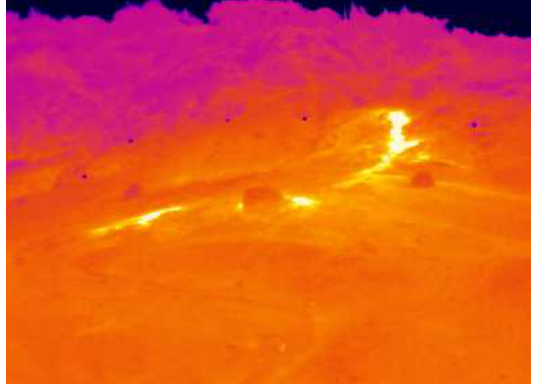
Figure 2. General thermal view of the geothermal site